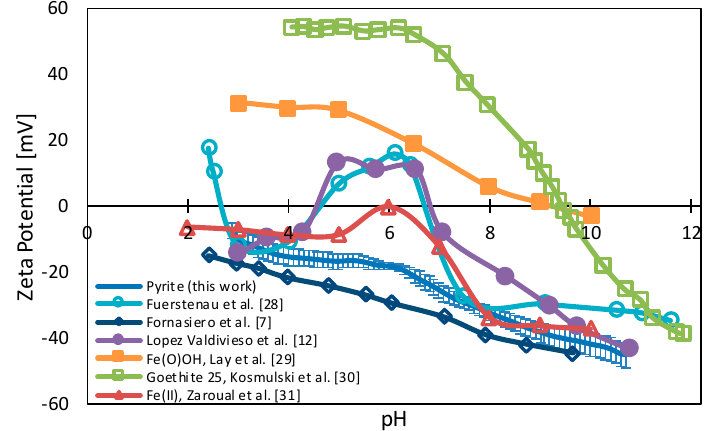
Figure 1. Zeta potential of pyrite as a function of pH, from different authors, under different oxidation degrees, and its comparison with different ferric species and states.